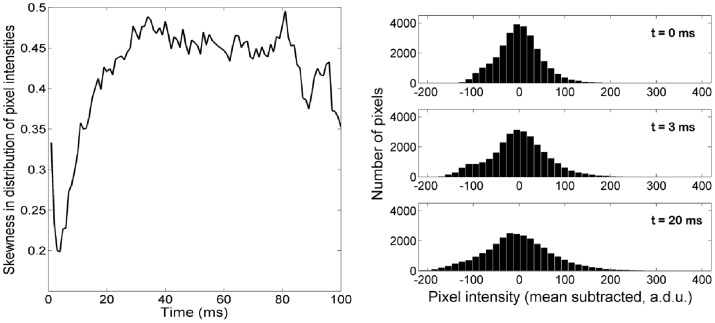
Evolution in cone waveguiding over time.Left: Skewness in the distribution of pixel intensities, as a function of time, for the averaged pseudo-sequence. The minimum occurs at 3 ms. Right: Mean-subtracted histograms from the averaged pseudo-sequence, at t = 0 ms, 3 ms and 20 ms.